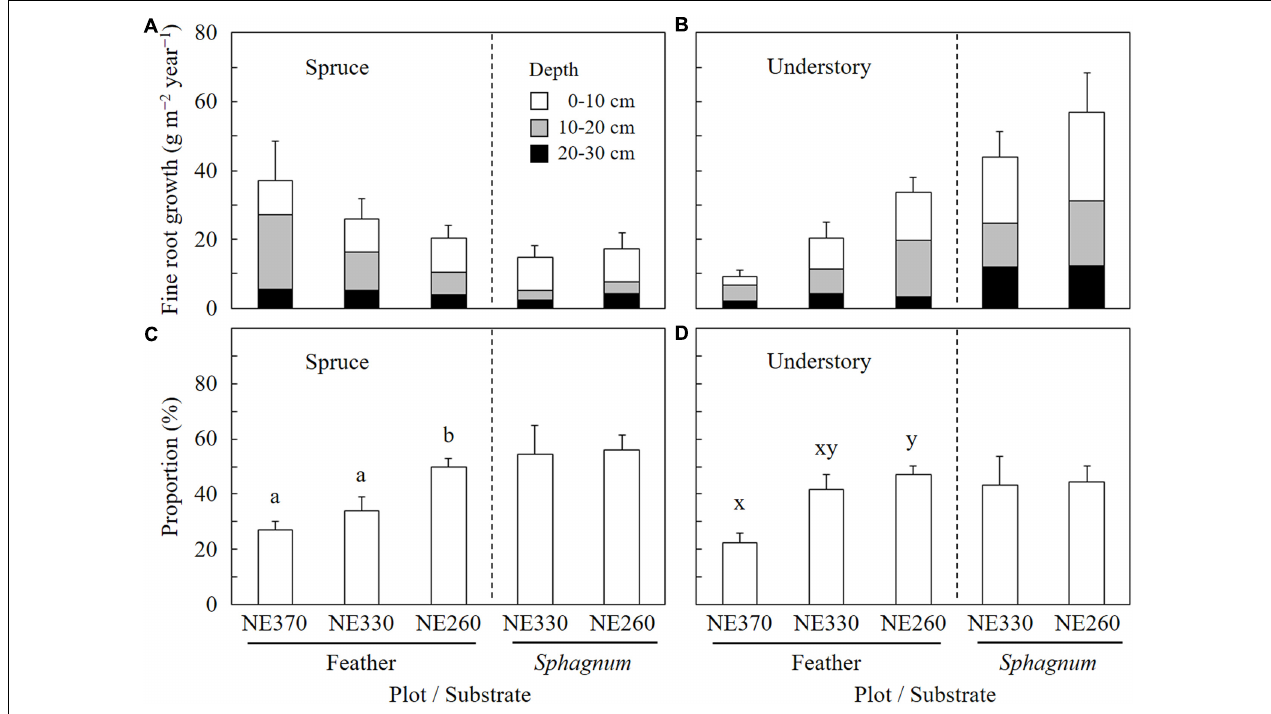
FIGURE 4 | Vertical distribution of fine root growth of black spruce and understory plants in feather or Sphagnum -moss substrates at NE360, NE330, and NE260 plots [ (A) fine root growth rates of black spruce; (B) those of understory plants; (C) proportions of fine root growth at the depth of 0–10 cm in total fine root growth (0–30 cm) of black spruce; (D) those of understory plants]. White, gray, and black columns represent data in the depths of 0–10, 10–20, and 20–30 cm, respectively (A,B) . Data shown are mean + SE ( N = 9). Different alphabetical letters indicate significant difference between the plots within each moss substrate